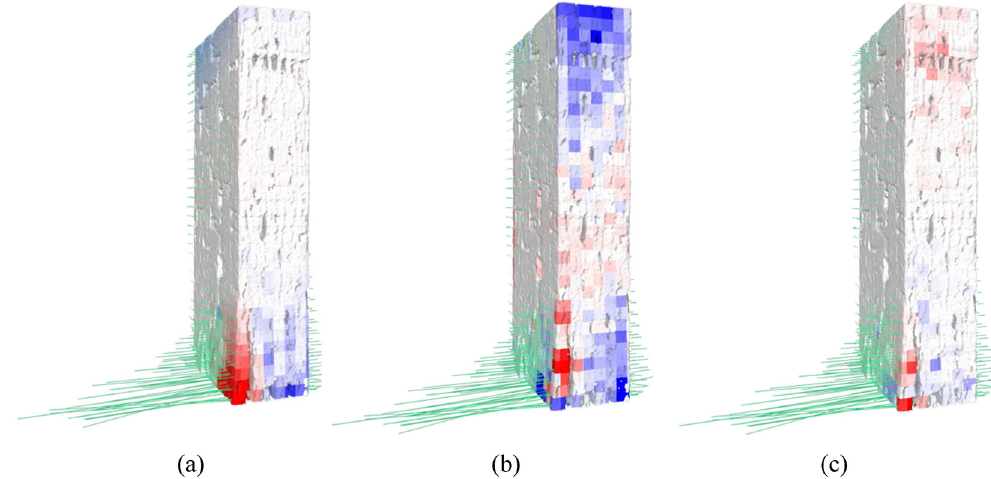
Figure 10: Displacement variation under maximum loading calculated by DVC: ( a ) X - direction, ( b ) Y - direction, and ( c ) Z -